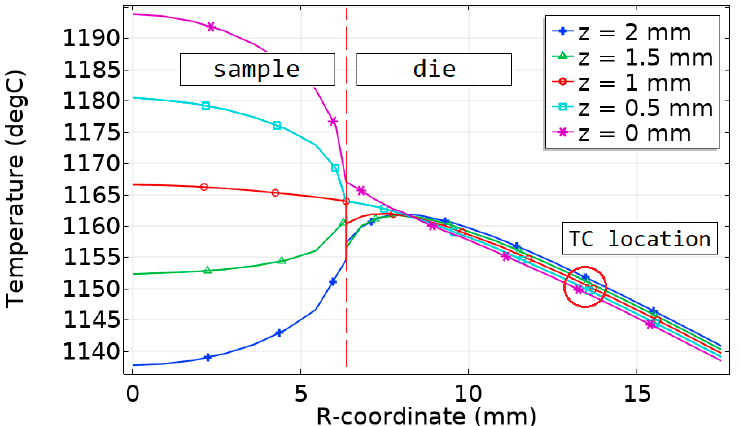
Figure 6. The sintering temperature in the Si-Ge sample and the mold along the radial direction for different z -coordinates for the sintering time t = 900 s. Red circle in the graph indicates the location of thermocouple aperture.